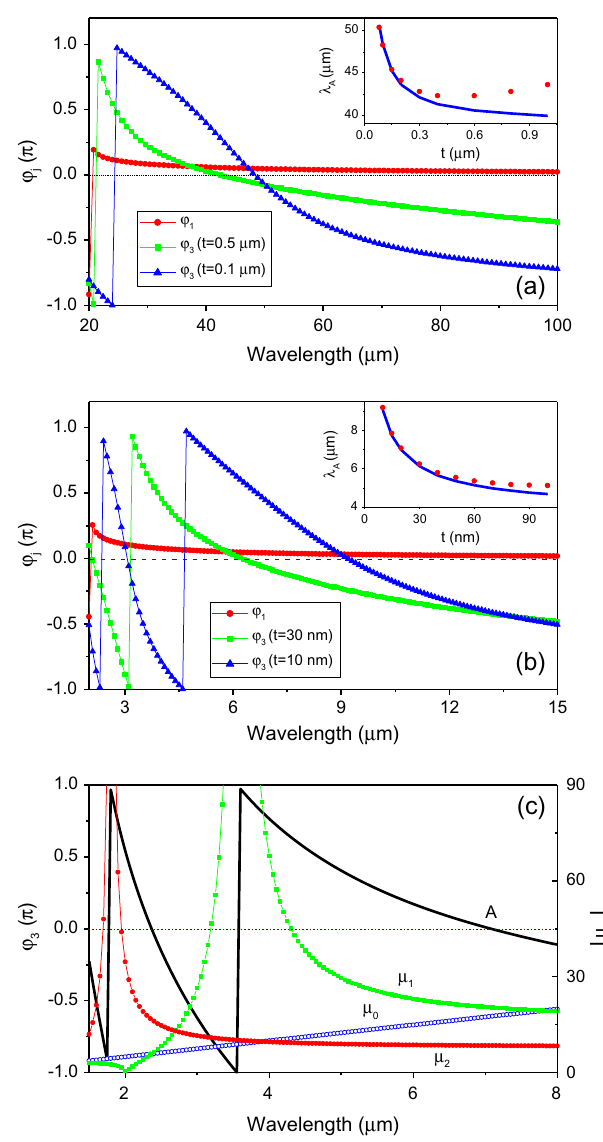
Figure 8. (a) Phase shift in the THz band for two spacer thickness t = 0.1 and 0.5 l m ( d = 20 l m, a = 0.5 l m); (b) Phase shift in the infrared region for t = 10 and 30 nm ( d = 2000 nm, a = 50 nm). The inset of (a) and (b) shows, respectively, the zero-phase point A as a function of t for the two frequency band, where the circles represent the theoretical results and the line a simple HFP model. The correspondence (in the infrared region) between the phase shift u 3 (the line) and l j j ( m = 0, 1, 2) are shown in (c), where m d = 2000 nm, a = 50 nm, and t = 20